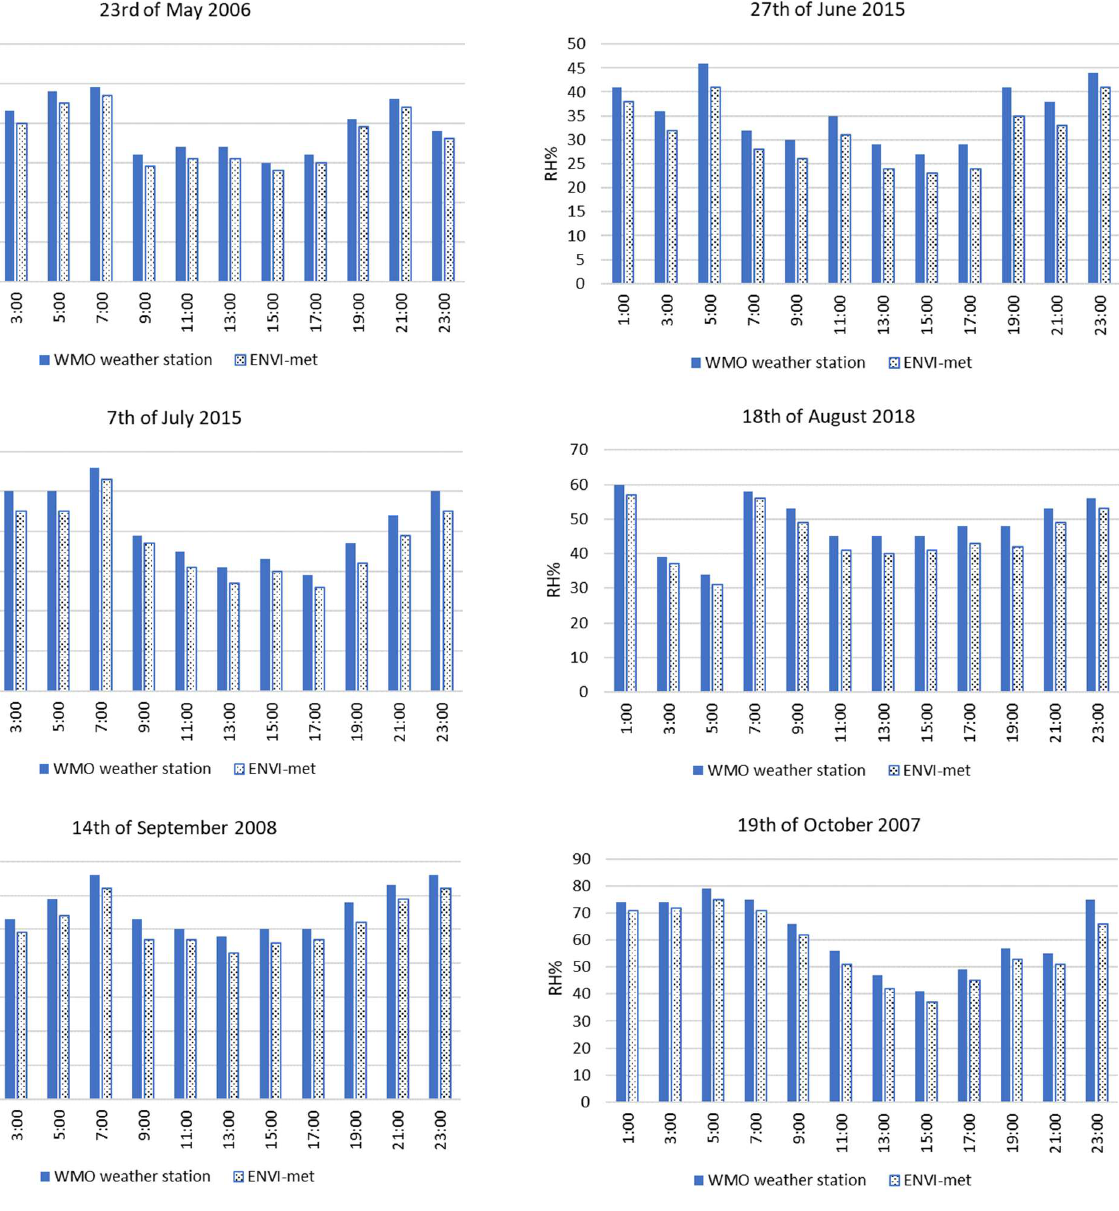
Figure 7. Variation in average relative humidity reported by the WMO and the ENVI-met simulated outcomes for the representative days of summer. Table 3. Statistical evaluation of the Envi-met model based on